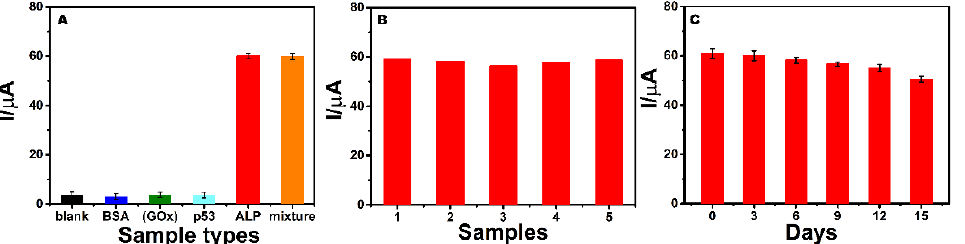
Figure 8. Selectivity studies of the immunosensor after incubating with blank, various interferences (100U L − 1 BSA, 100U L − 1 GOX, 100U L − 1 p53, 100U L − 1 a mixture of all), and 60U L − 1 ALP ( A ), reproducibility studies of the immunosensor under the same experimental conditions for detecting ALP with the concentration of 60 U L − 1 ( B ), storage stability studies of the immunosensor over time ( C